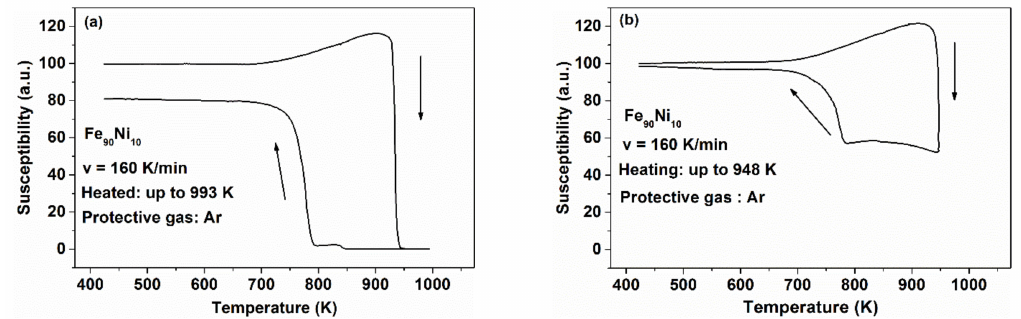
Figure 16. Hysteretic phenomena in the thermomagnetic curves for Fe 90 Ni 10 samples upon heating and cooling up to di ff erent maximum temperatures. ( a ) 993 K, and ( b ) 948 K measured at a heating and cooling rate of 160 K / min. Adopted from [86], with permission from Trans Tech Publication,